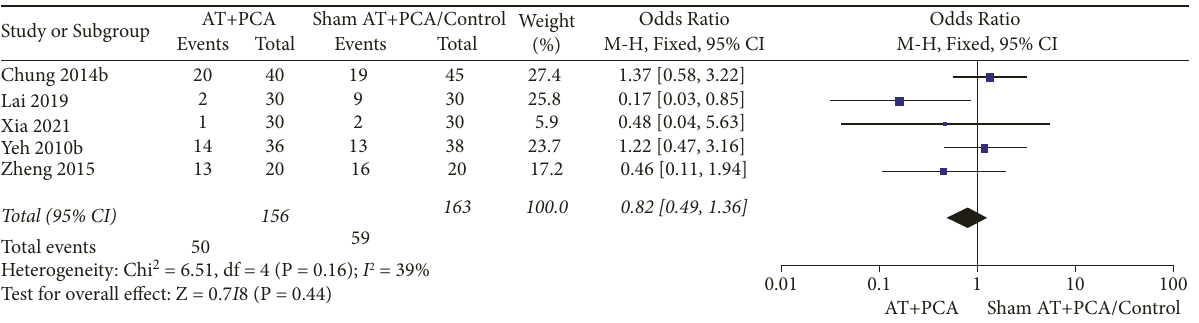
Figure 6: Forest plots of the incidence of PONV. AT: